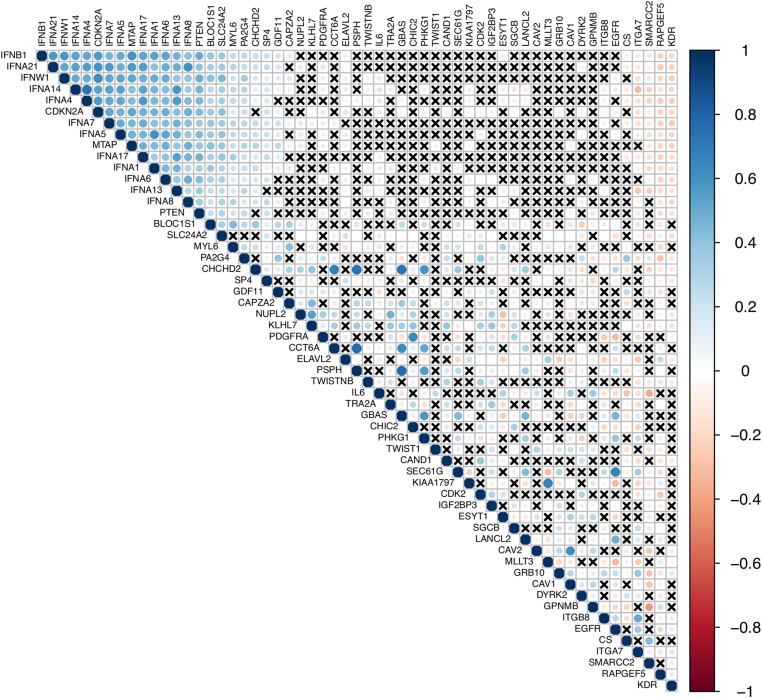
Correlation of the expression in TGCA The Cancer Genome Atlas dataset considering the genes deleted or amplified in our datasets. The crosses indicate that there was no statistical difference in the correlation.